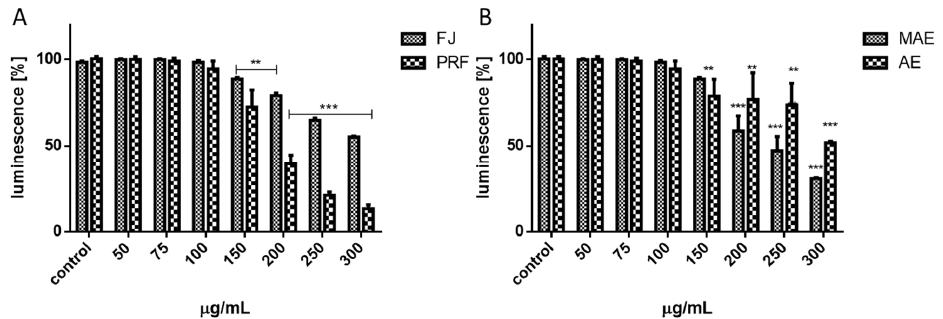
Figure 6. The influence of 24 h of exposure of V. opulus juice (FJ) and PRF (phenolic rich fraction) ( A ), MAE (methanol-acetone extract) and AE (acetone extract) ( B ) on ATP level in Caco-2 cells determined by ATP luminescent assay. Control cells were not exposed to any compound but the vehicle; values are means ± standard deviations from at least three independent experiments; statistical significance was calculated versus control cells (untreated), ** p ≤ 0.01, *** p ≤ 0.001.